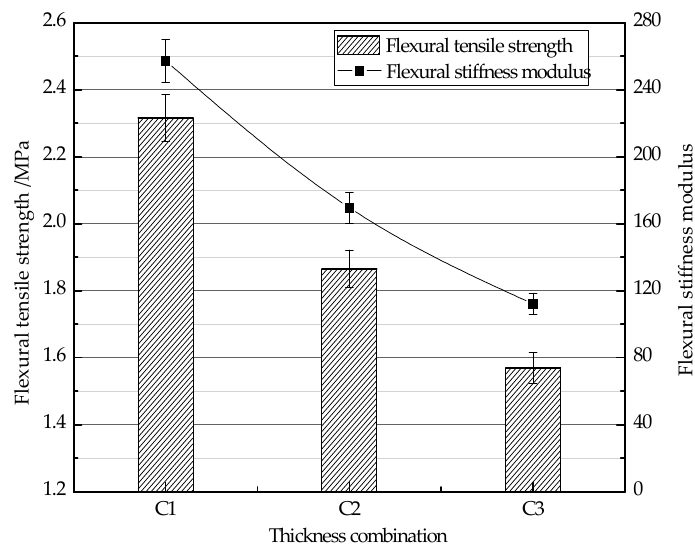
Figure 5. Flexural tensile strength test results of different thickness structure combinations.